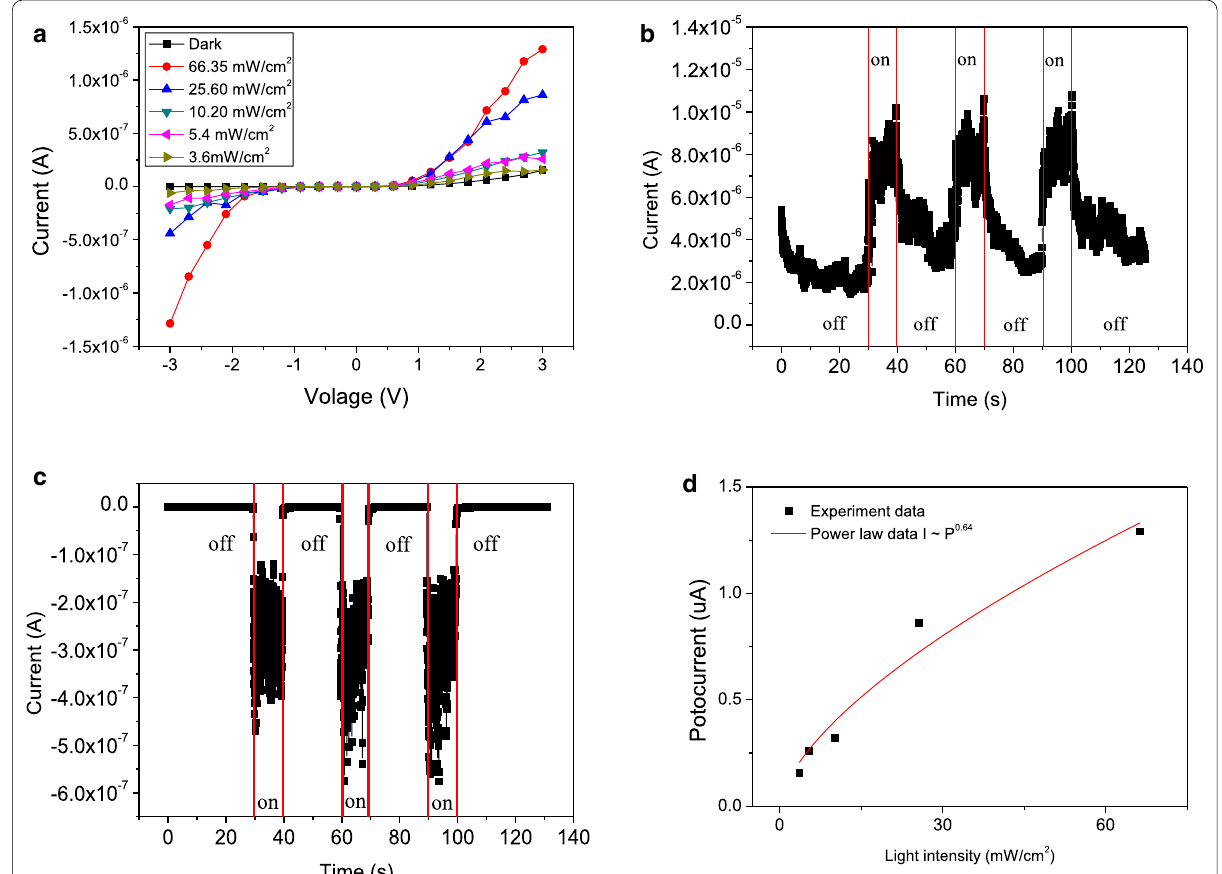
Fig. 7 a I–V curves of a ZnO‑NW‑based sensor under 365 nm light irradiation of different intensities. b Time‑resolved photoresponse of a ZnO‑NWs‑based sensor at 3 V in reverse‑biased mode under white UV illumination by switching on and off. c Time‑resolved photoresponse of a + ZnO‑NWs‑based sensor at 3 V in reverse‑biased mode under white UV illumination by switching on and off. d Photocurrent of a ZnO‑NW‑based − sensor at 3 V in reverse‑biased mode as a function of light intensity and corresponding fitting curve using the power −